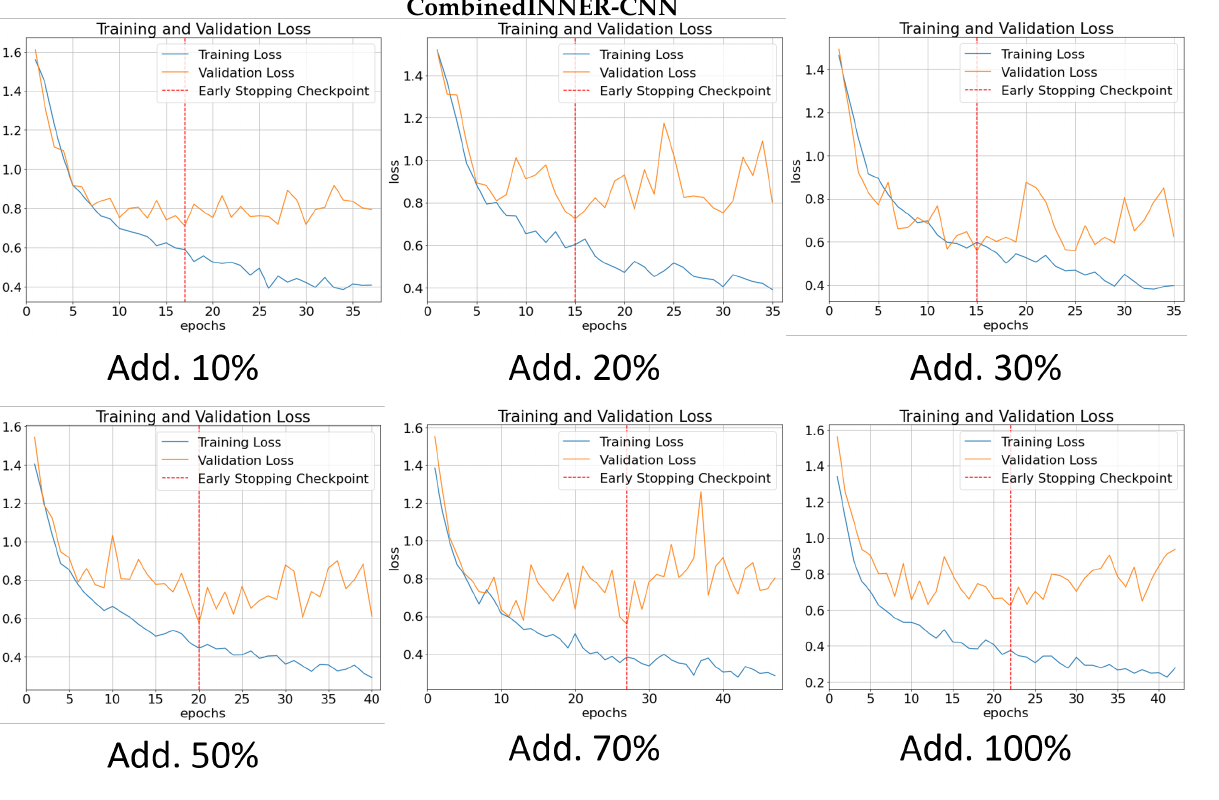
Figure A3. The training and validation losses of the models fed with increments of 10% of additional double-barred beach data with the inner bar